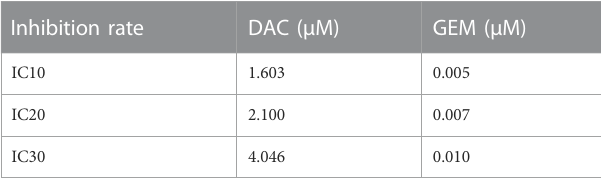
TABLE 1 IC10, 1C20, and IC30 of DAC and GEM in NK92MI